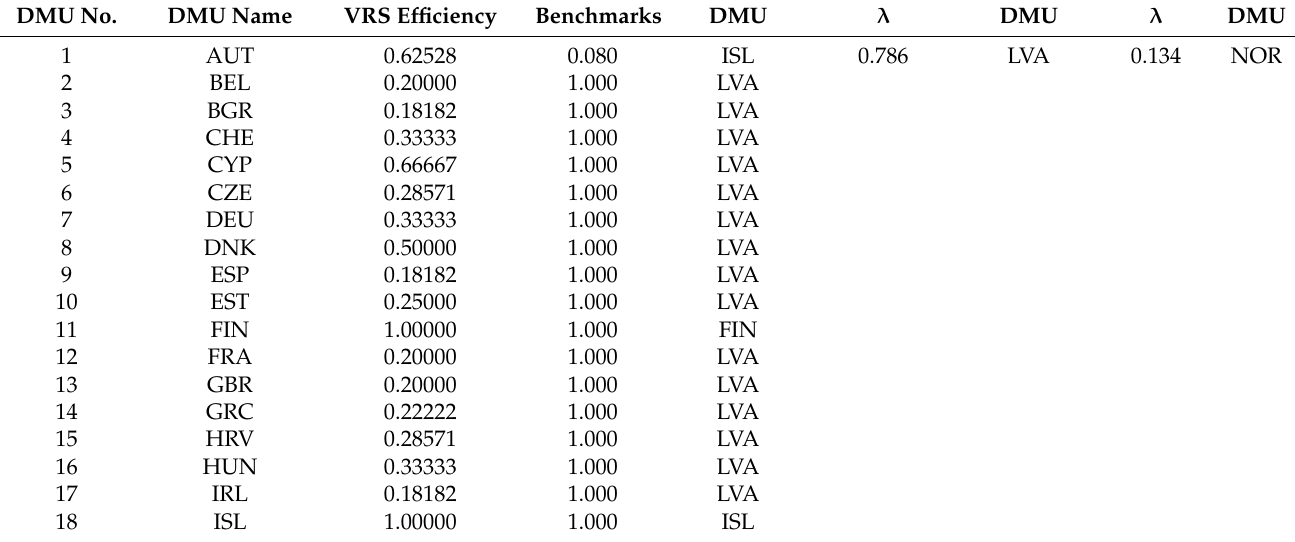
Table A12. Input-Oriented VRS Efficiency of EPS in 2009. Source: Authors’ calculations in DEAFrontier. DMU